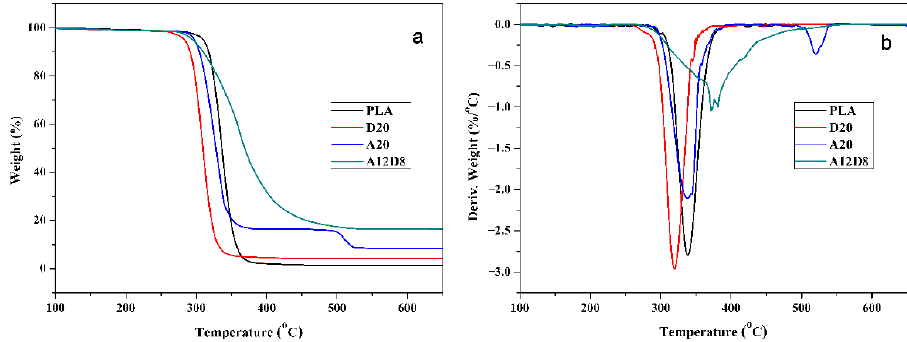
Figure 4. PLA, D20, A20 and A12D8 thermograms: ( a ) TGA and ( b ) DTG.